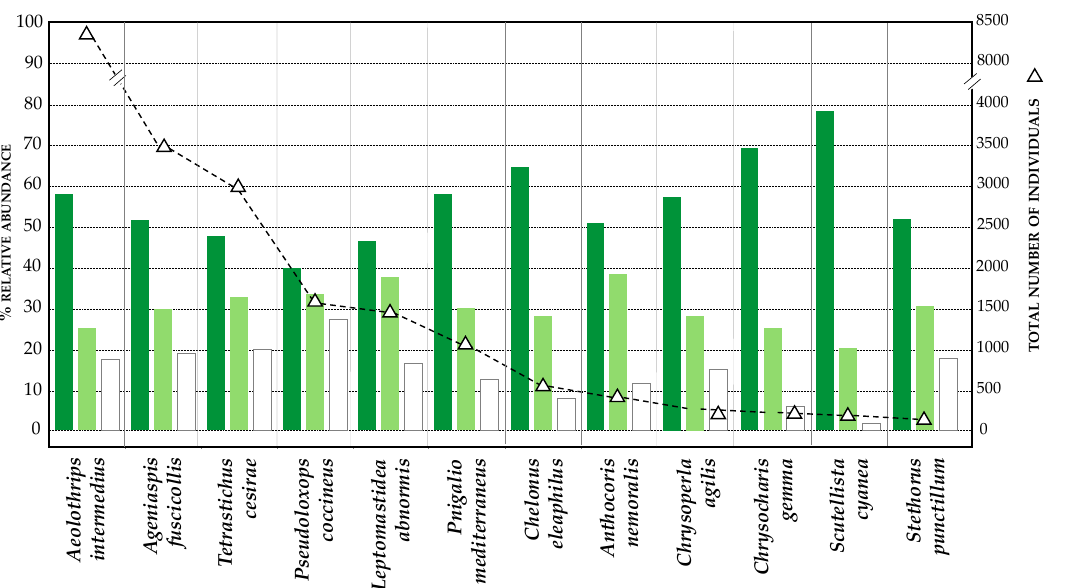
ANOVA F= 23.4 p < 0.001